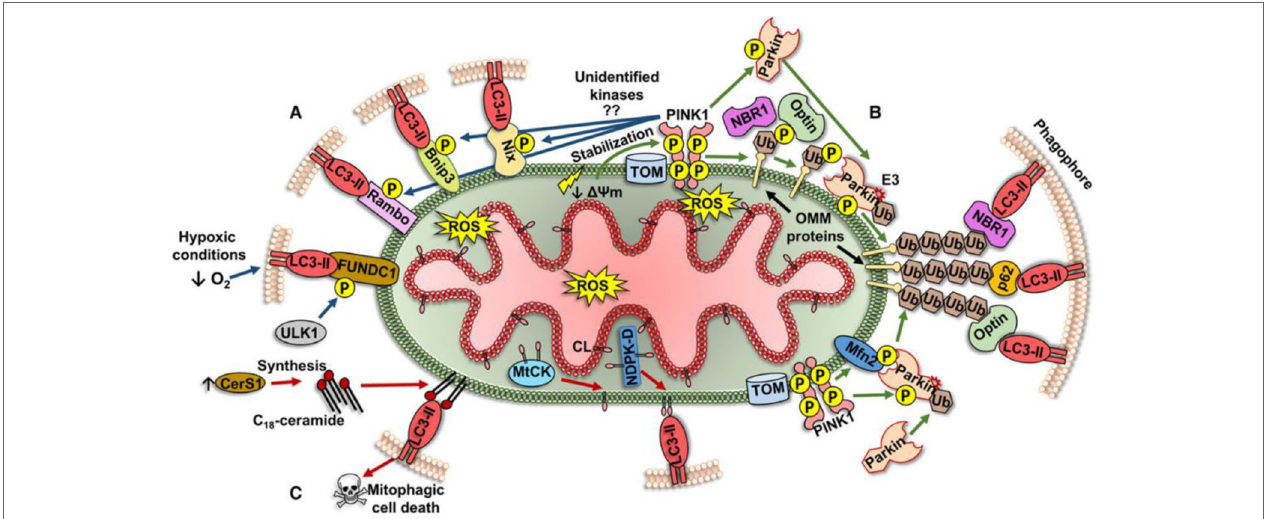
FIGURE 2 | Three different types of mitophagy pathway (Ploumi et al., 2017).